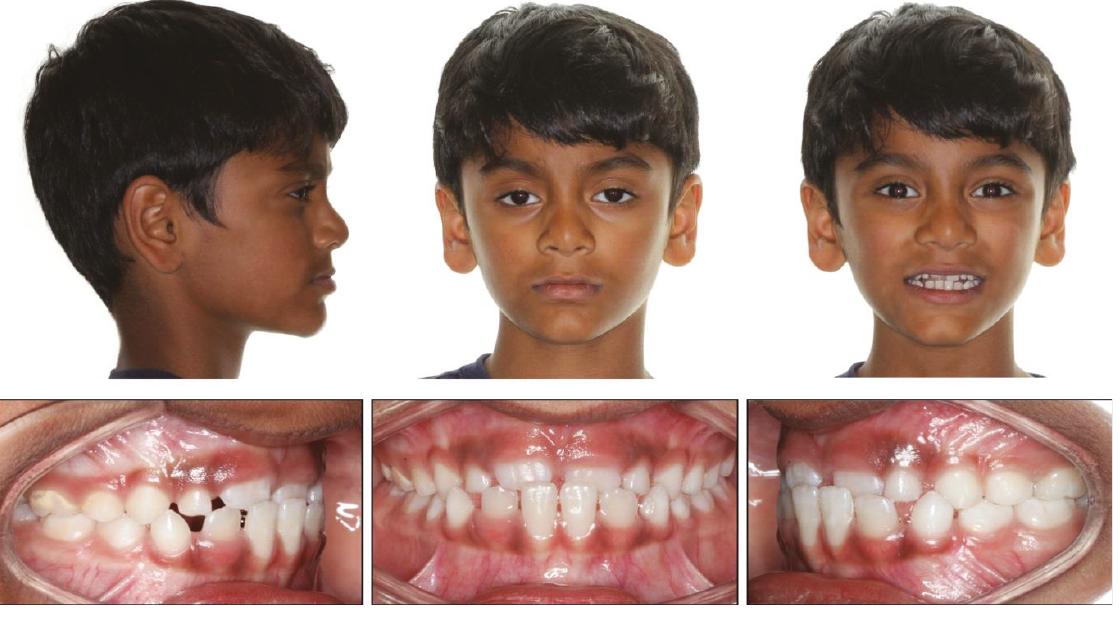
Figure 2: Pretreatment composite.